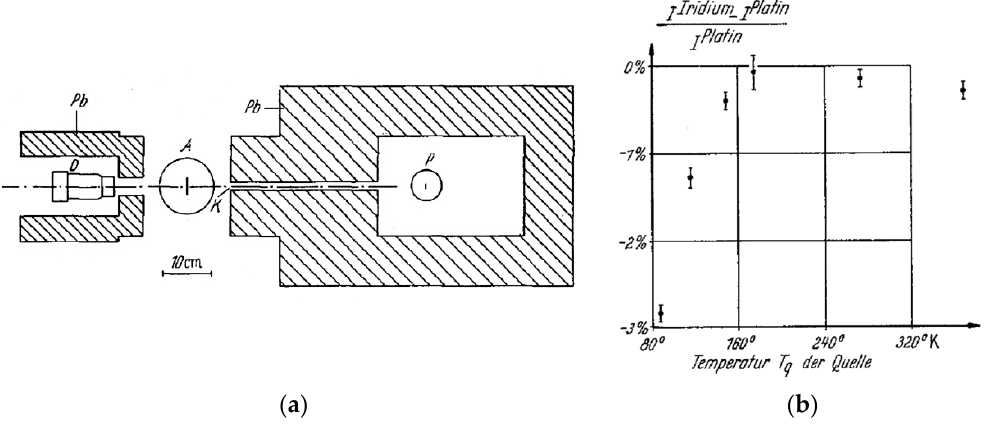
Figure 3. Scheme ( a ) of the experimental device used for the absorption measurements of gamma photons of iridium-129 (D = scintillation counter; A = absorber-cryostat; K = collimator; P = source-cryostat). Experimental data ( b ) recorded by simultaneously cooling source and absorber. Reproduced from [8].